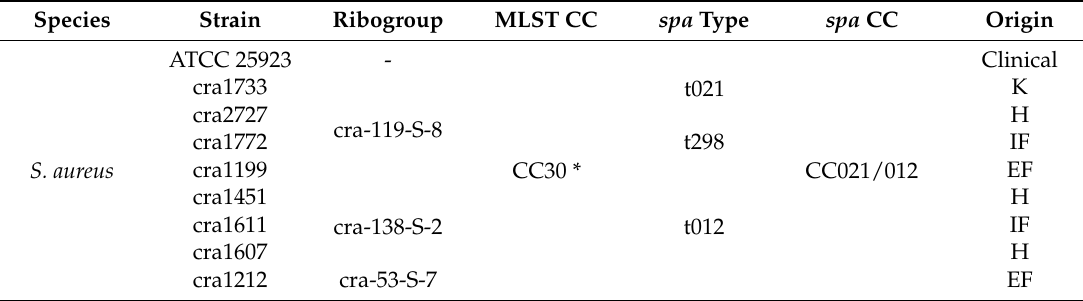
Table 2. Characteristics of S. aureus strains.